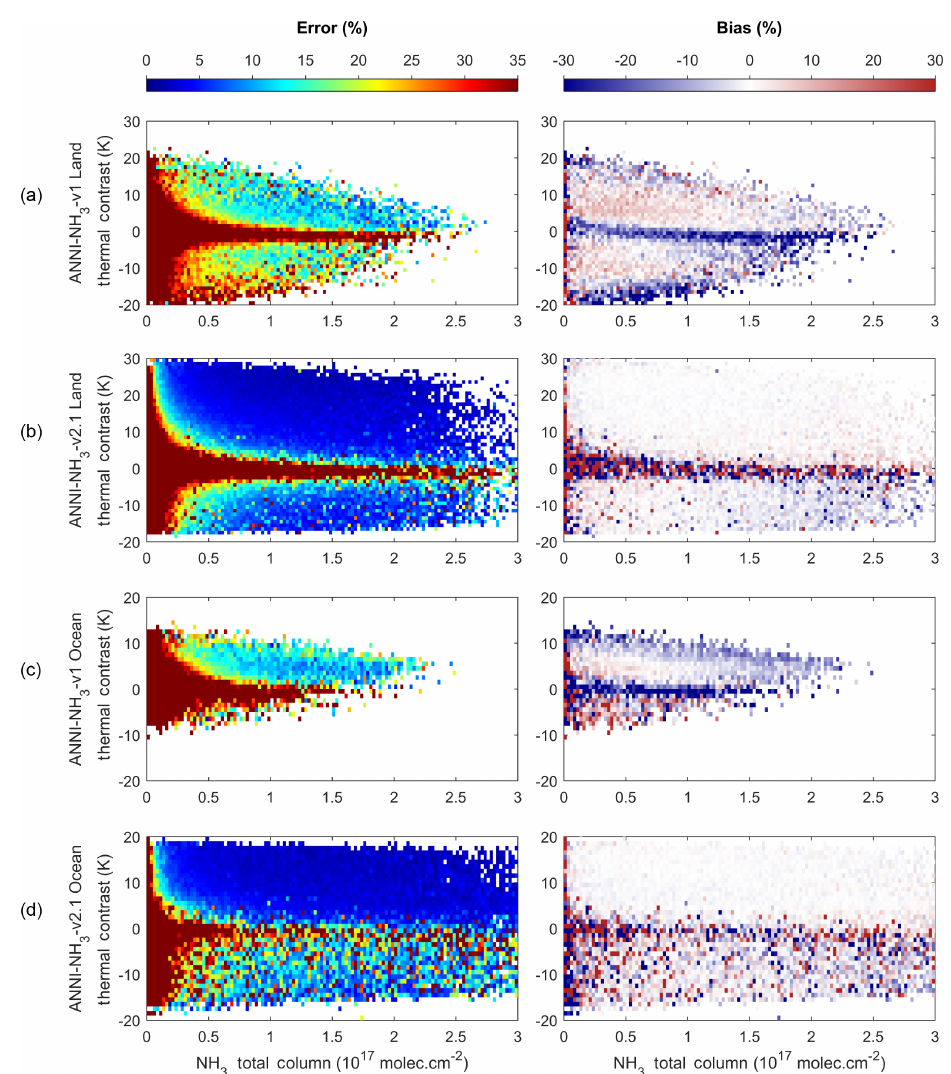
Figure 1. Neural network training performance in terms of mean error (left column, %) and bias (right column, %), for land (a, b) and sea (c, d) and for ANNI-NH 3 -v1 (a, c) vs. ANNI-NH 3 -v2.1 (b, d)